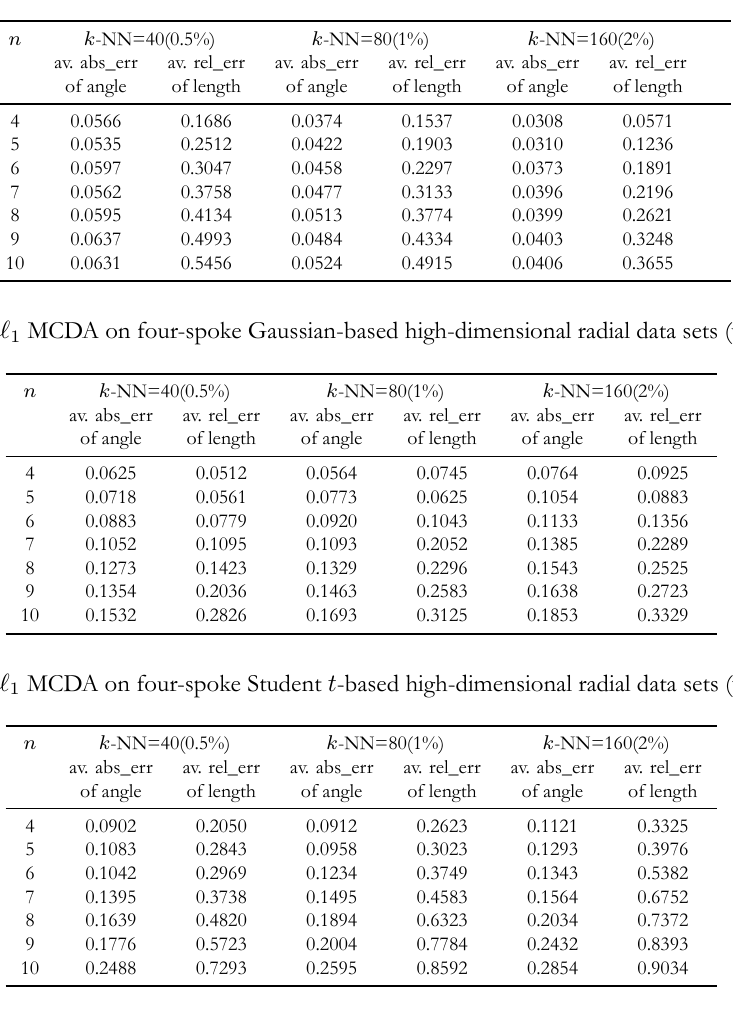
Table 6: Results of ℓ 1 MCDA on four-spoke Student t -based high-dimensional radial data sets